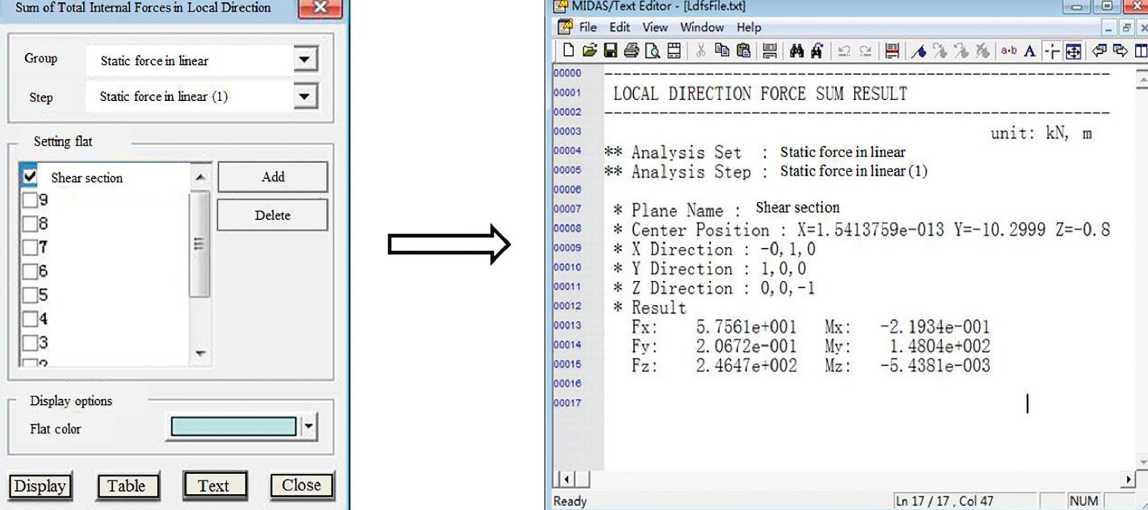
Figure 3: Sum of internal forces in specific